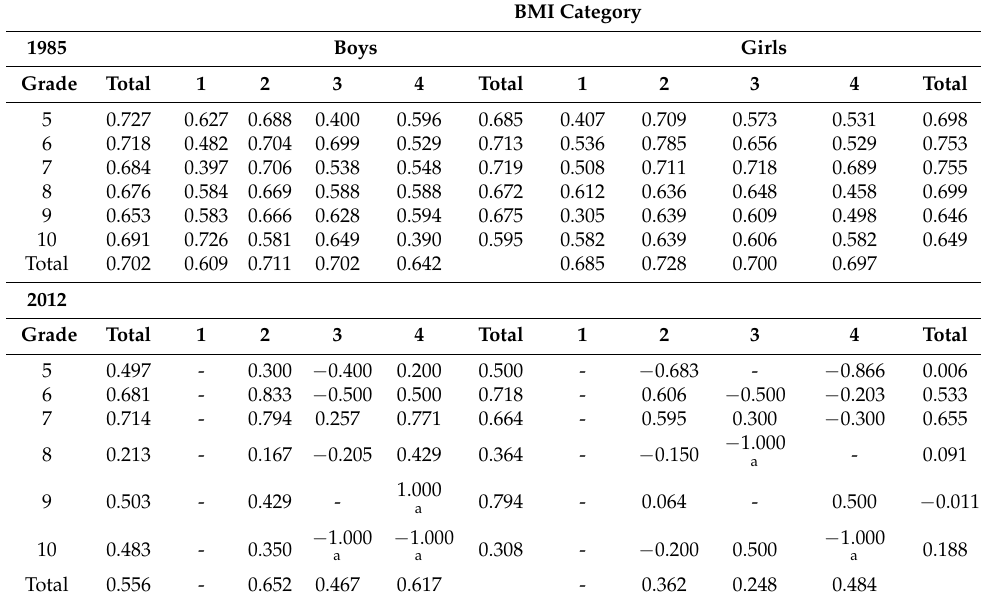
Table 4. The correlation between inside and outside PE ranking (BMI: 1 = Underweight, 2 = Normal weight, 3 = Overweight, 4 = Obese).